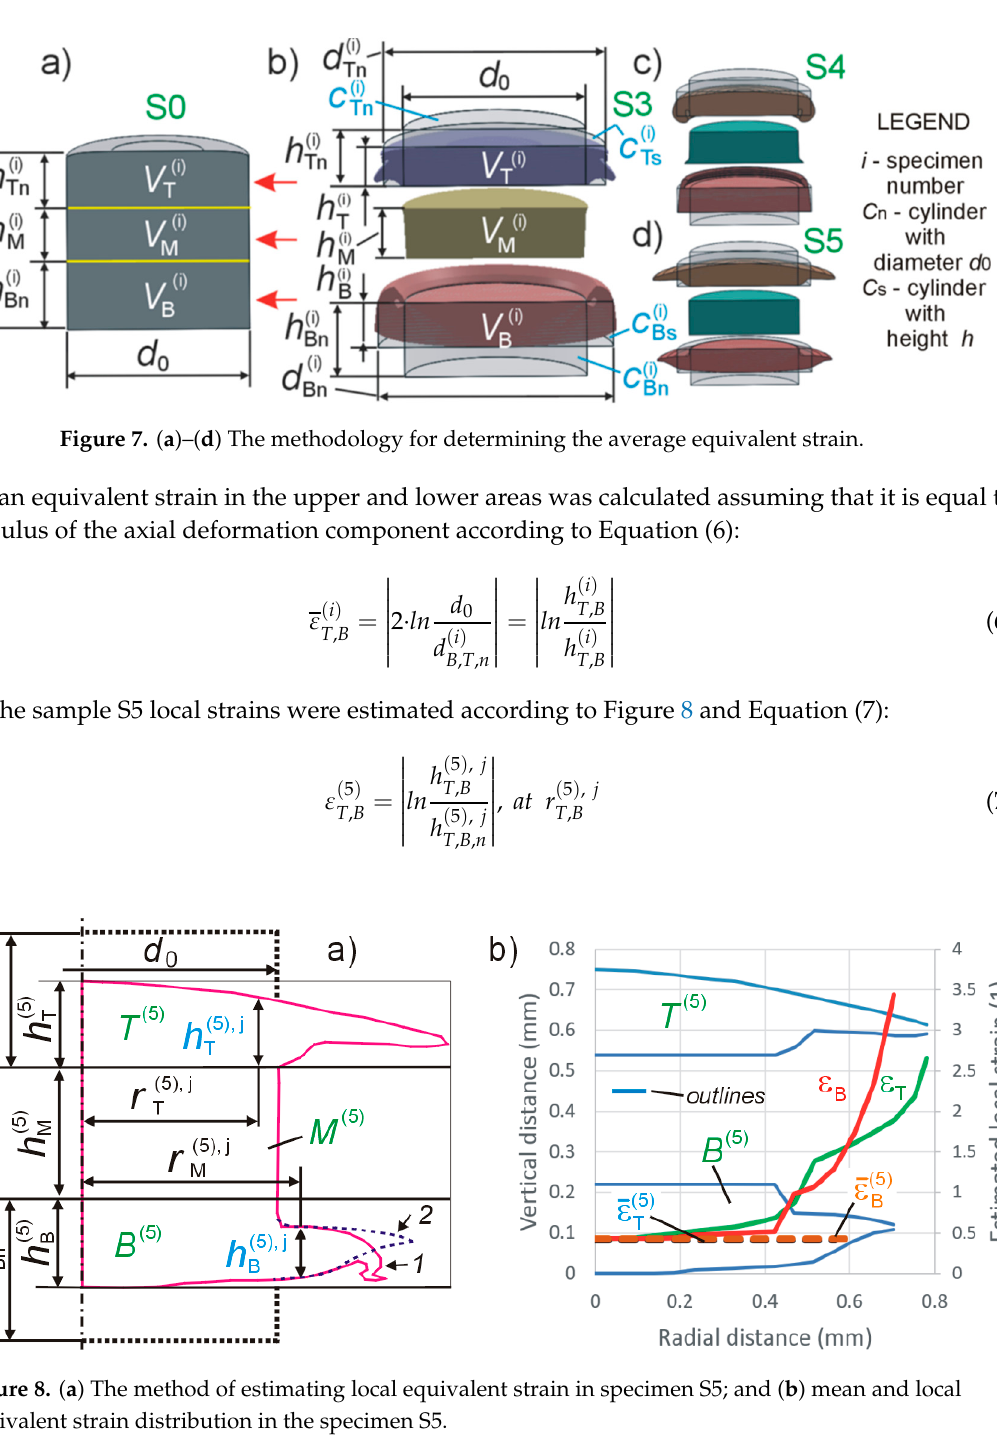
Figure 7. The methodology for determining the average equivalent strain.